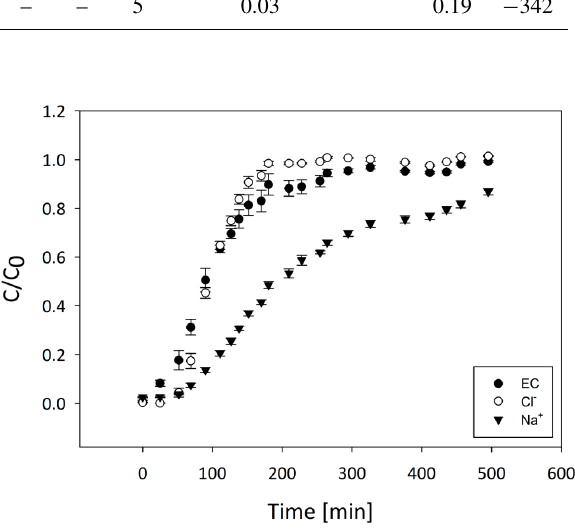
Figure 4. EC, Cl − and Na + corrected saturated breakthrough curves in saturated peat over time. Each point is an average of three samples; error bars are standard error of mean. Errors were not ac- counted for in the